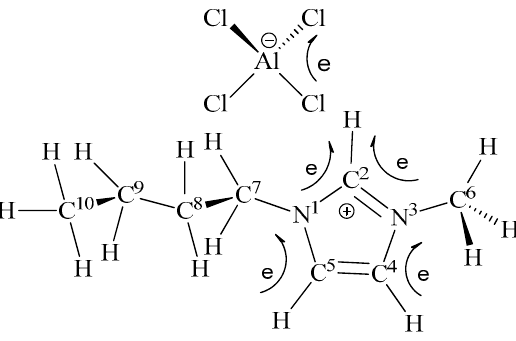
Figure 3. Direction of the charge transfer when AlCl 3 approaches the ion pair unit (C 4 mim-Cl).